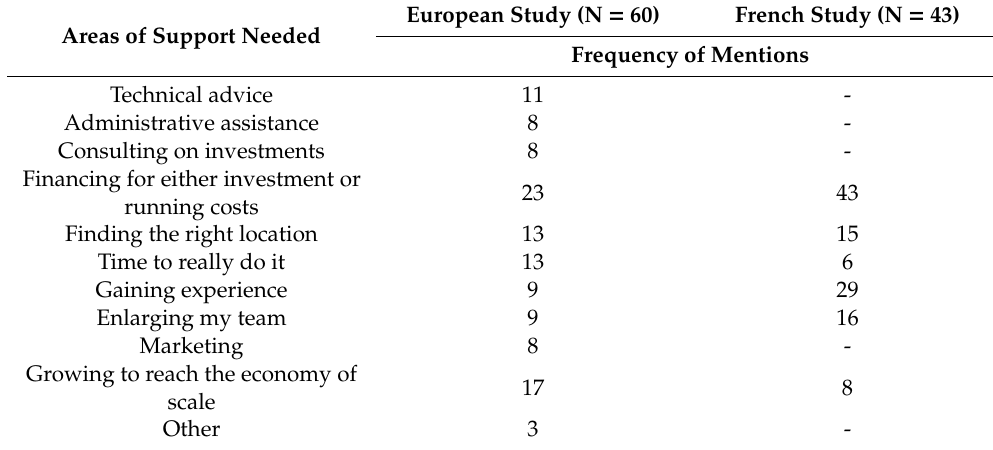
Table 7. Areas of support needed in commercial aquaponics. Answers to the question: Today, what do you lack most so that your project runs better / more quickly (one or more answers could be selected)? Areas of Support